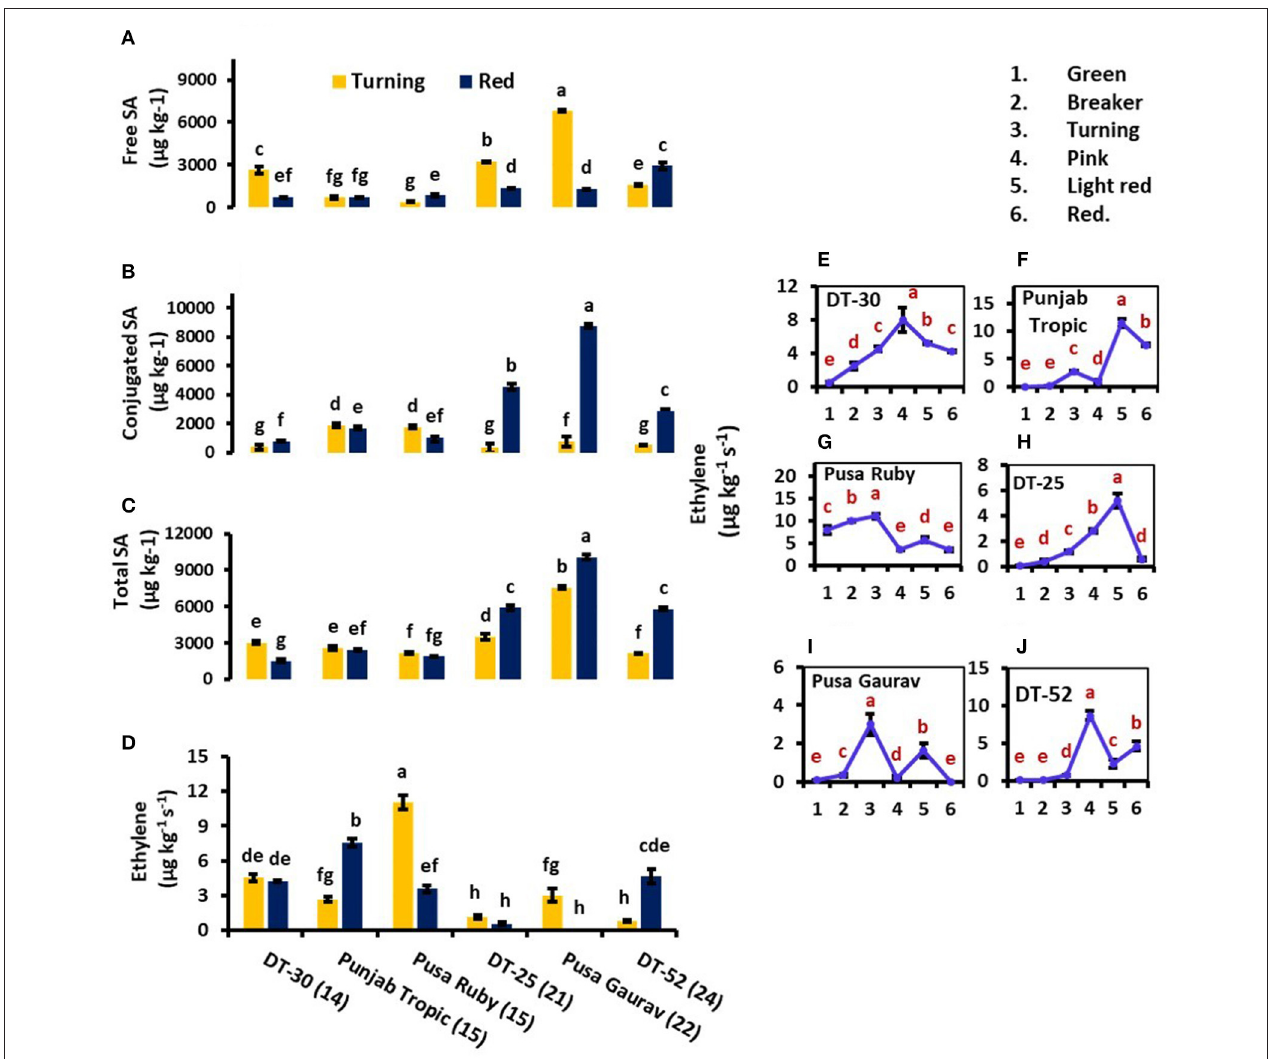
FIGURE 3 | Comparison of free salicylic acid (SA) (A) , conjugated SA (B) , total endogenous SA (C) , and ethylene (ET) evolution (D) at turning and red stages of tomato fruit development. Bottom axis represents the name of tomato lines, and numbers enclosed in parentheses represent shelf life. ET evolution from mature green to red stage of individual tomato fruit line (E–J) . Each graph represents the mean of three replications, and vertical bars represent ± SE. Some error bars are hidden behind marker. Different letters represent significant differences at P <